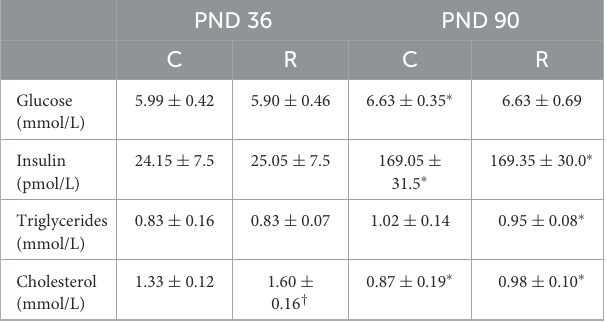
TABLE 3 Biochemical